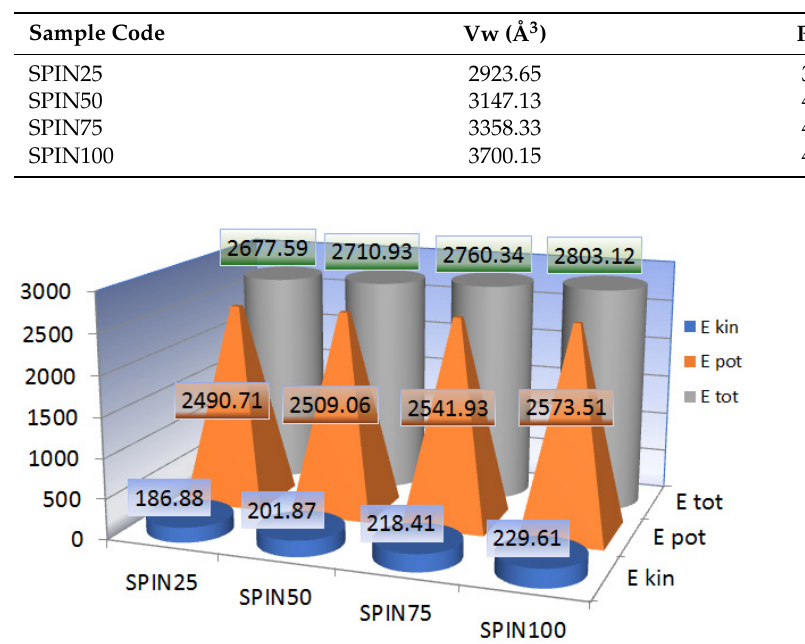
Figure 3. Total energy (Etot), potential energy (Epot) and kinetic energy (Ekin) values computed for the studied PI-based supramolecular systems.